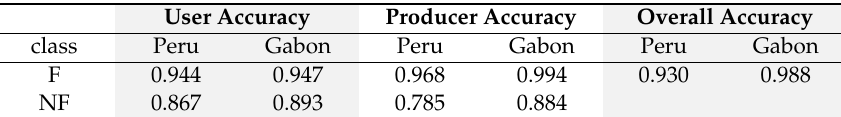
Table 1. Forest / Non-Forest mask validation Peru and Gabon. Table 1. Forest/Non-Forest mask validation Peru and Gabon.